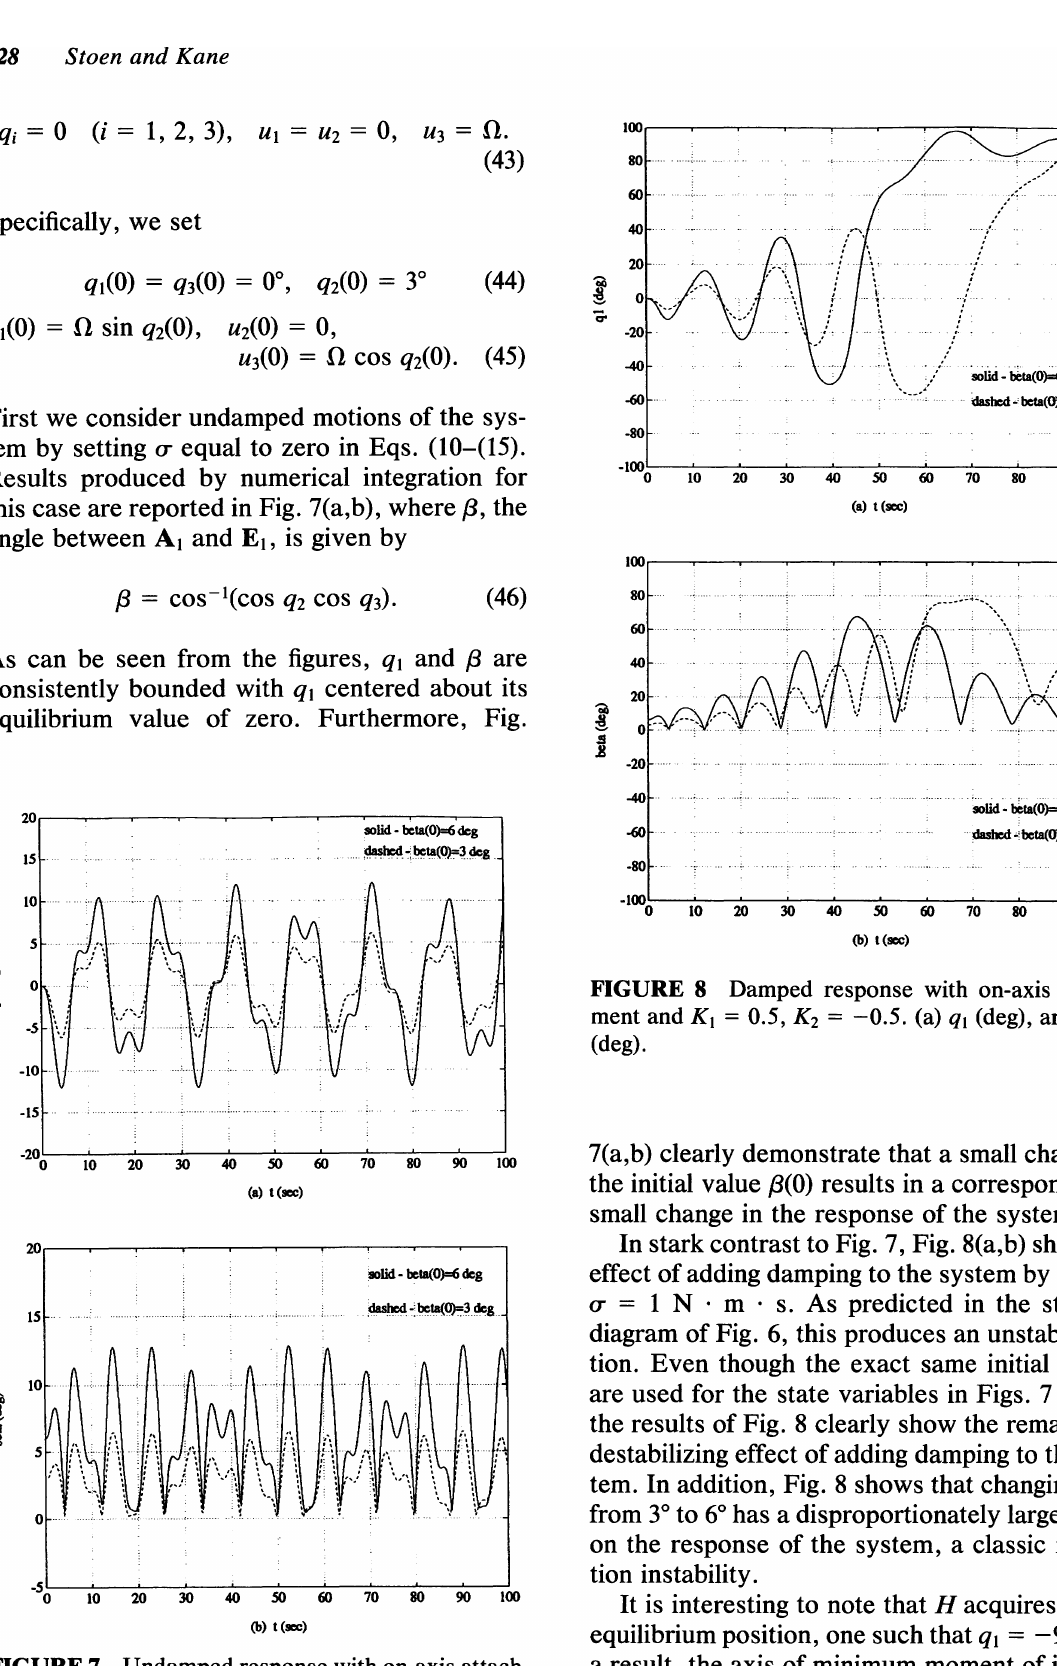
FIGURE 7 Undamped response with on-axis attach ment and K, = 0.5, K2 = 0.5. (a) q) (deg), and (b) f3 (deg).